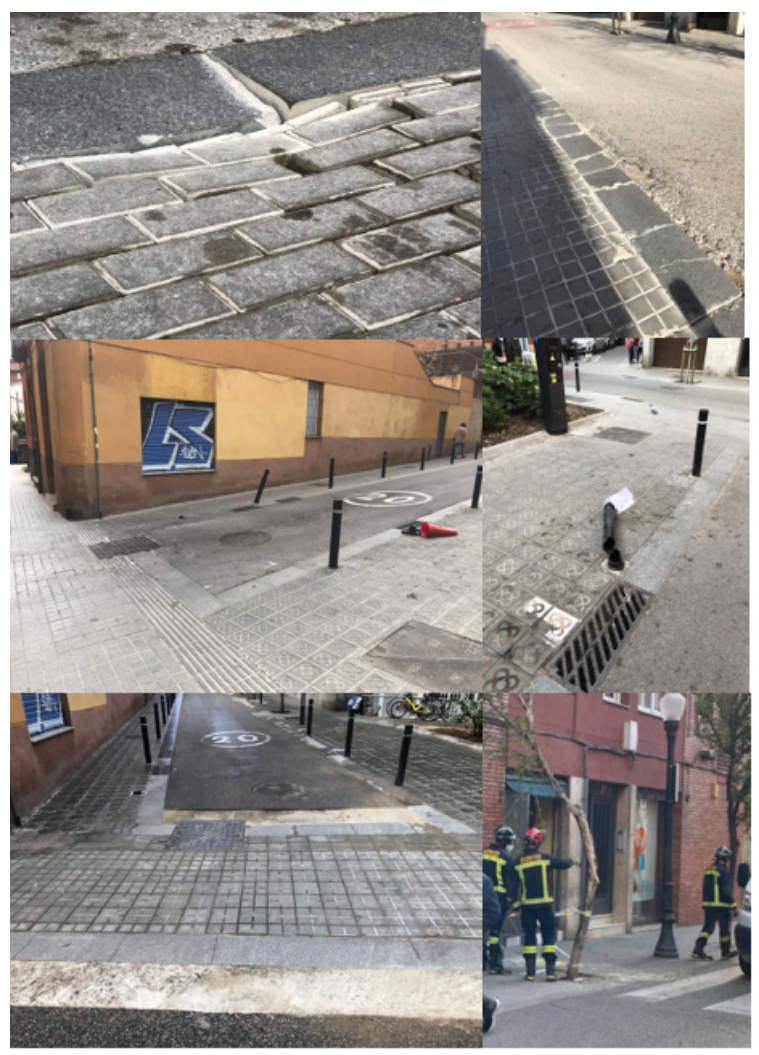
Figure 11. Some examples of the problems referenced in the main text between the P1 and P2 measurement points.